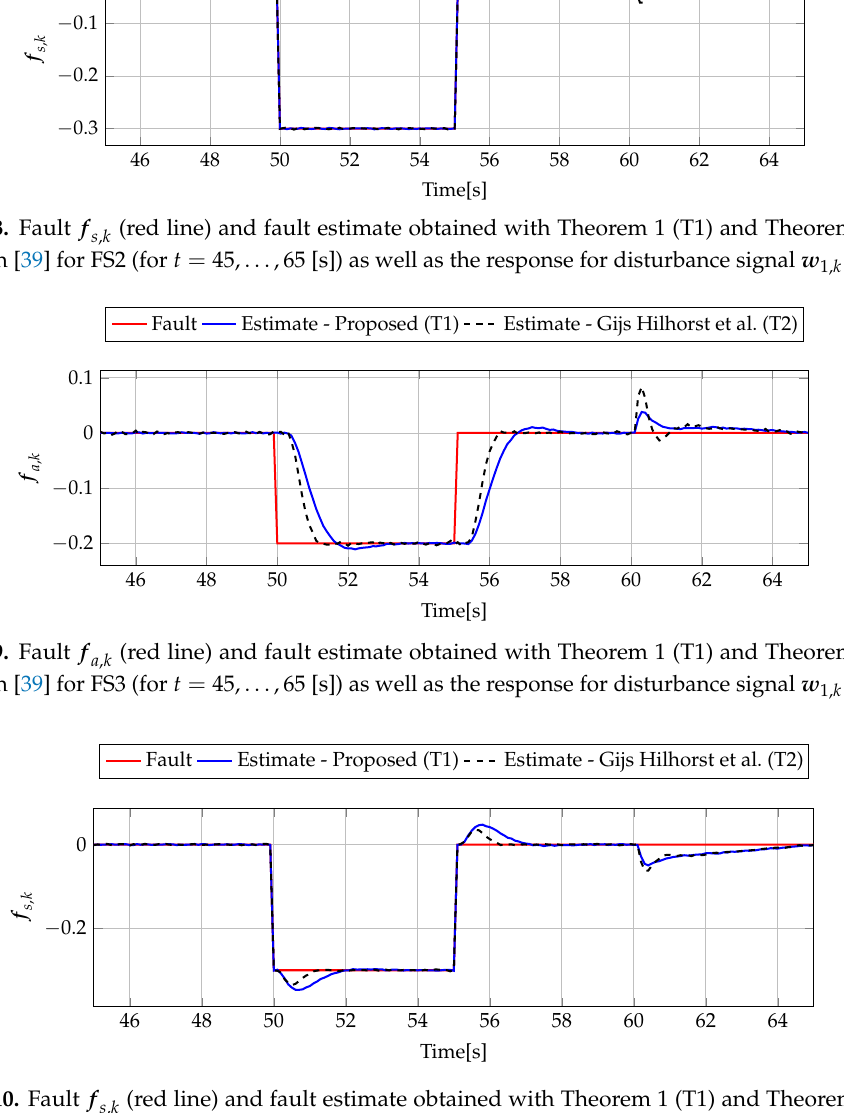
Figure 10. Fault f (red line) and fault estimate obtained with Theorem 1 (T1) and Theorem 2 (T2) s , k based on [39] for FS3 (for t = 45, . . . ,65 [s]) as well as the response for disturbance signal w 1, k